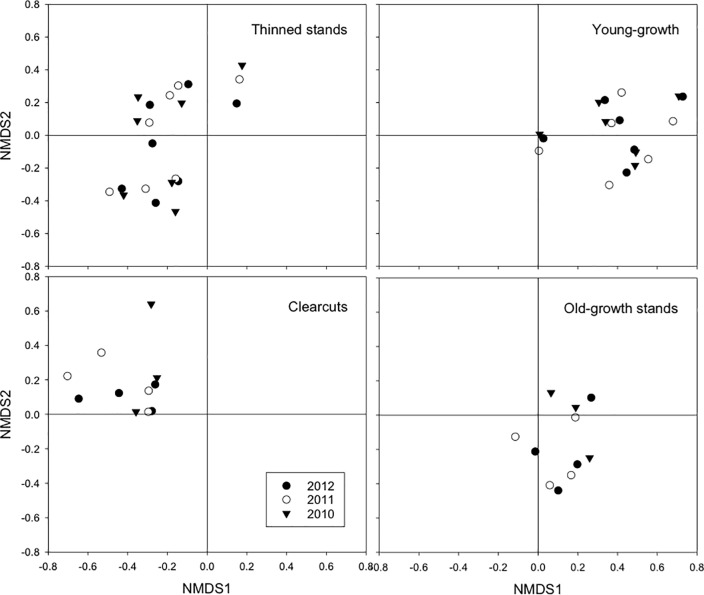
Values of non-metric multidimensional scaling (NMDS).NMDS1 and NMDS2 values for habitat and food variables in each of four habitat types on Prince of Wales Island, Alaska from 2010–2012.